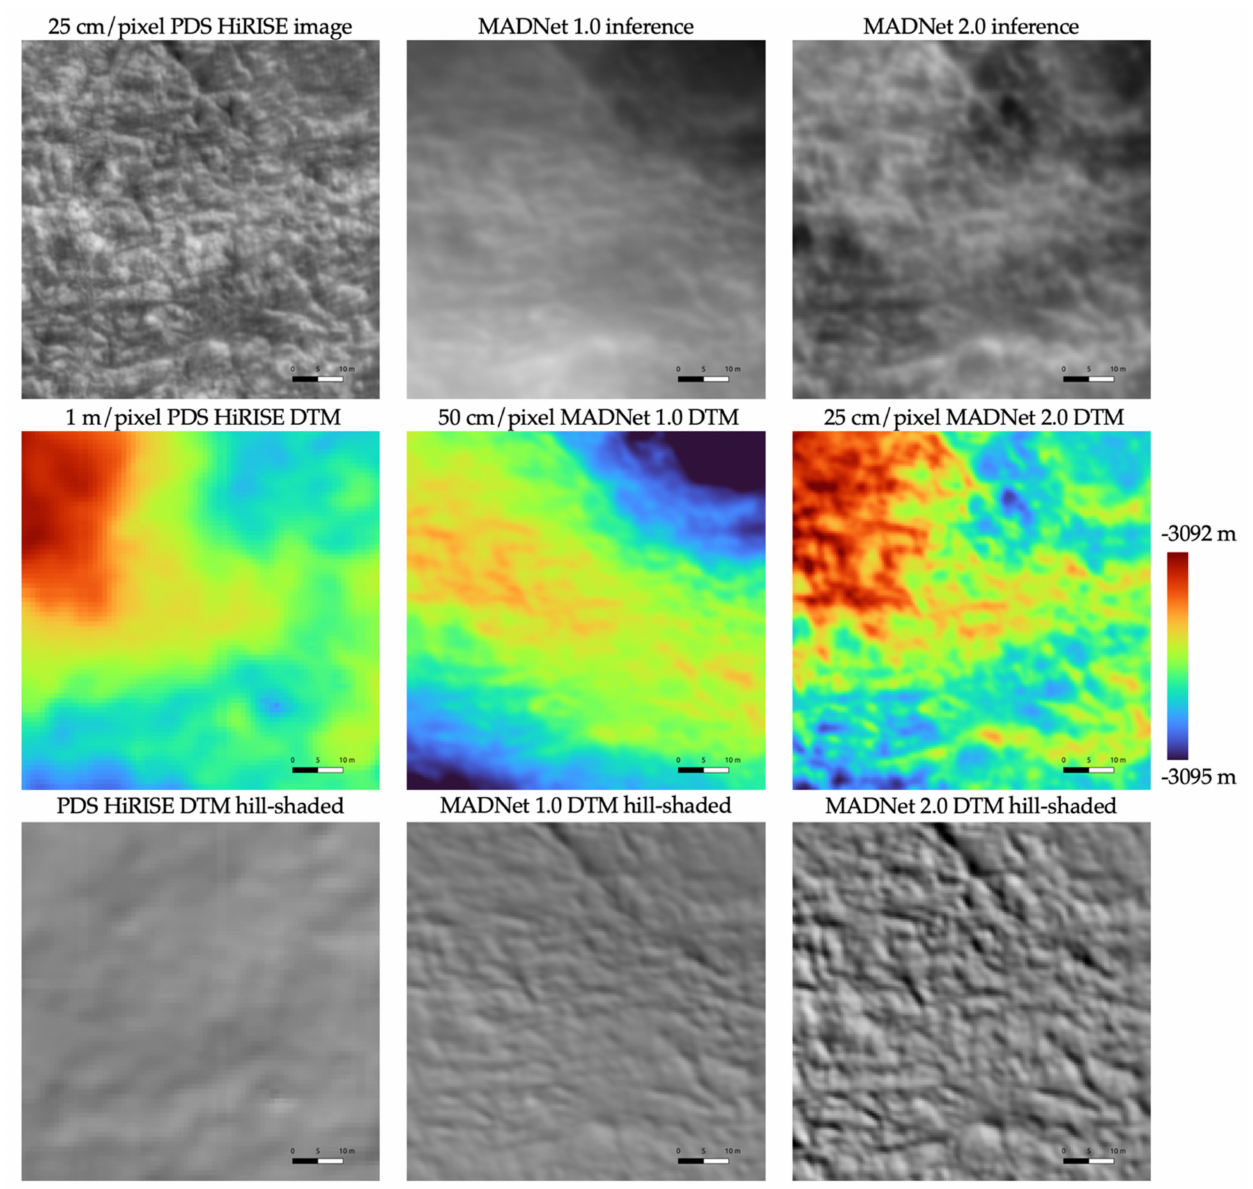
Figure 5. An example of the MADNet 1.0 and MADNet 2.0 results from a single input image tile from HiRISE (ESP_003195_1985_RED). 1st row: input HiRISE image tile, initial height map inferences (values range from 0 to 1) from MADNet 1.0 and MADNet 2.0; 2nd row: PDS HiRISE DTM (DTEEC_003195_1985_002694_1985_L01) cropped for the same area, final DTM results from MADNet 1.0 and MADNet 2.0; 3rd row: hill-shaded (azimuth: 225 ◦ ; altitude: 30 ◦ ; vertical exaggeration: 1) relief image of the PDS HiRISE DTM, MADNet 1.0 DTM, and MADNet 2.0